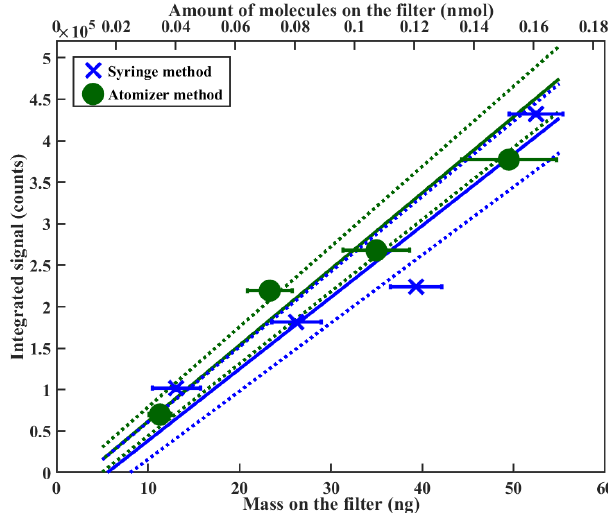
Figure 8. Sensitivity comparison between different calibration methods using PEG-7. The bottom x axis shows the deposited mass on the filter; the top x axis shows the same amount in nanomoles. Note that y axis error bars are too small to be seen in the figure. Fur- ther explanation of the error analysis is shown in the